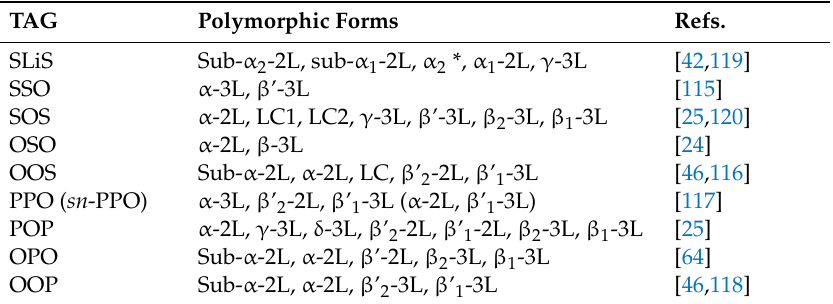
Table 4. Polymorphic forms in main saturated- cis -unsaturated mixed-acid TAGs.